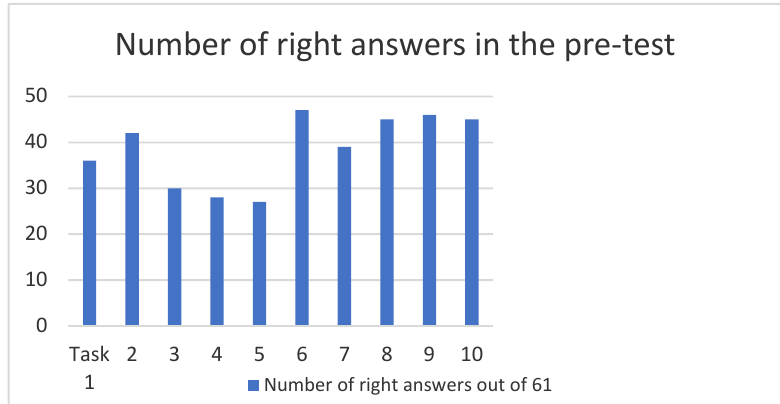
Figure 10. Results according to the tasks.